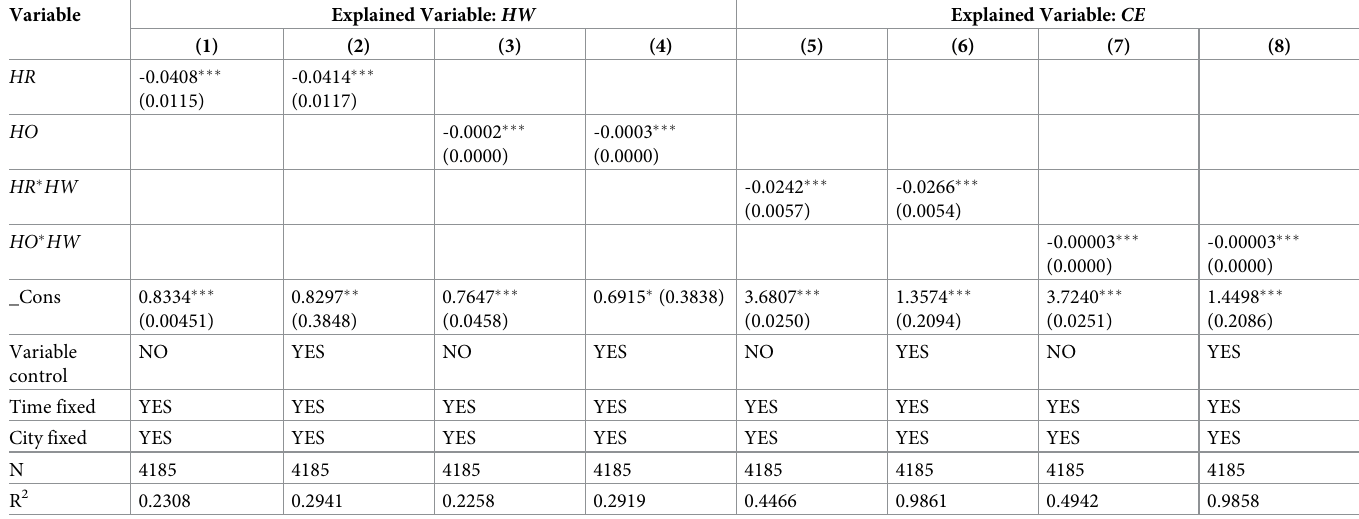
Table 6. Direct transmission